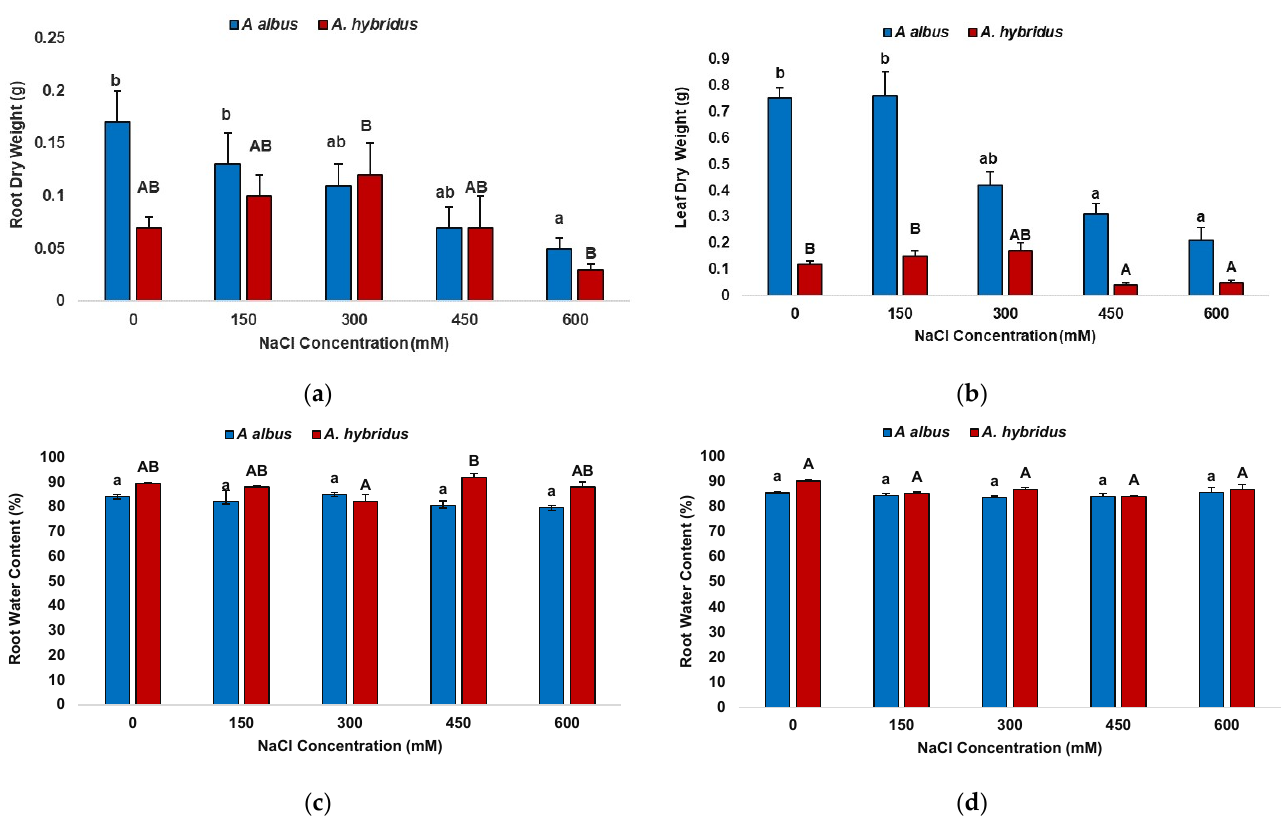
Figure 6. Dry weight of leaves ( a ) and roots ( b ), and water content of leaves ( c ) and roots ( d ) in the two Amaranthus species after one month of NaCl treatments. Means ± SE, n = 7. Same letters indicate homogeneous groups between treatments for each species, according to the Tukey test ( α = 0.05). Lower ‐ case letters were used for A. albus and capital letters for A. hybridus.